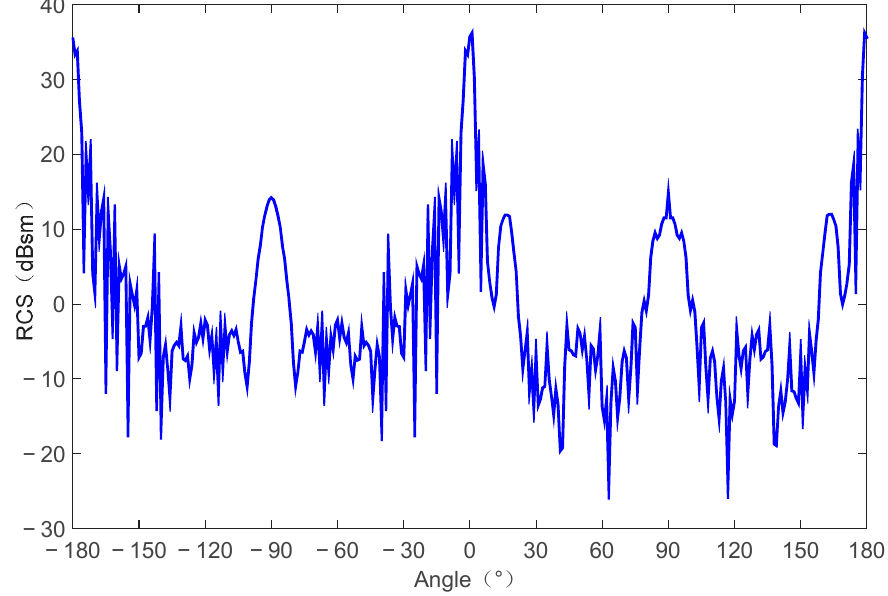
Figure 7. Radar cross-section distribution characteristics of a fighter aircraft.